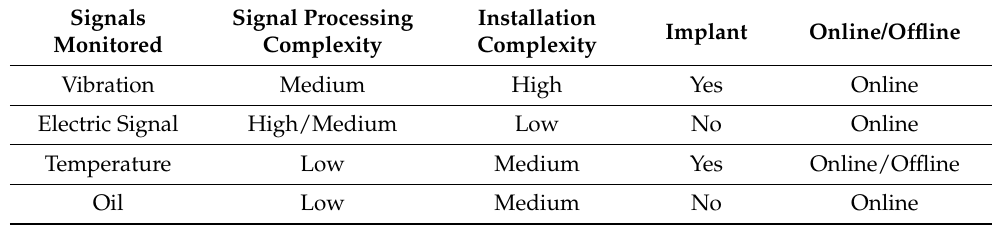
Table 1. Comparison of commonly used signals in wind